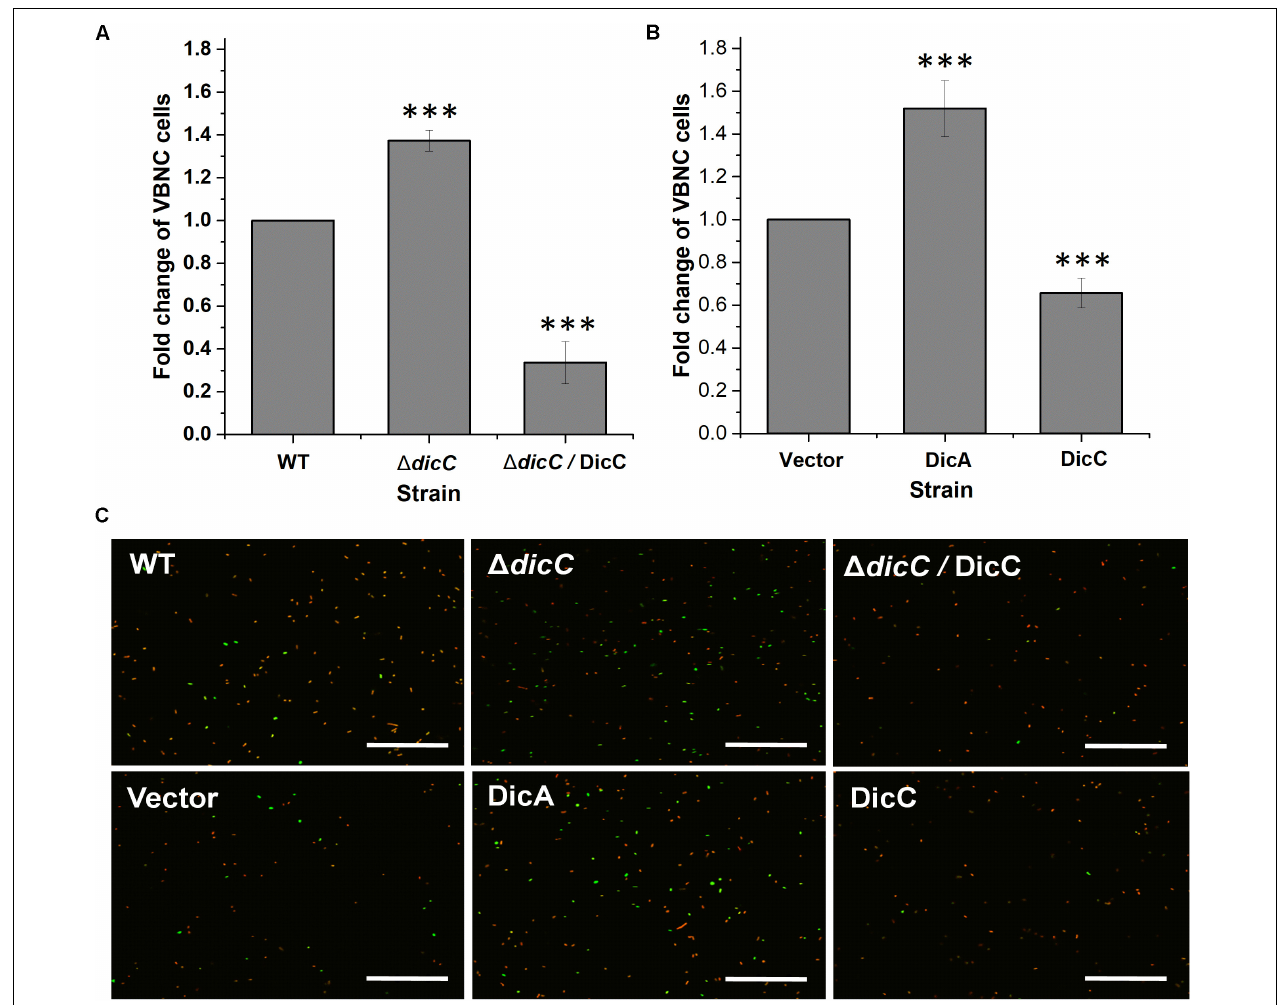
FIGURE 2 | Effects of DicA and DicC on the percent changes in the number of VBNC cells induced by HPCD. (A) Changes in VBNC cell percentage generated by HPCD in the WT strain, (cid:49) dicC mutant, and (cid:49) dicC /DicC strain. (B) Changes in VBNC cell percentage generated by HPCD in the vector strain, DicC strain and DicA strain. (C) Photomicrographs of VBNC cells stained with the LIVE/DEAD BacLight Bacterial Viability Kit and examined under a fluorescence confocal microscope. Green: viable cells, red: dead cells. Bar = 20 µ m. Error bars show the standard errors of the means. Significance was calculated by the t -test ( ∗ p < 0.05, ∗∗ p < 0.01, ∗∗∗ p <